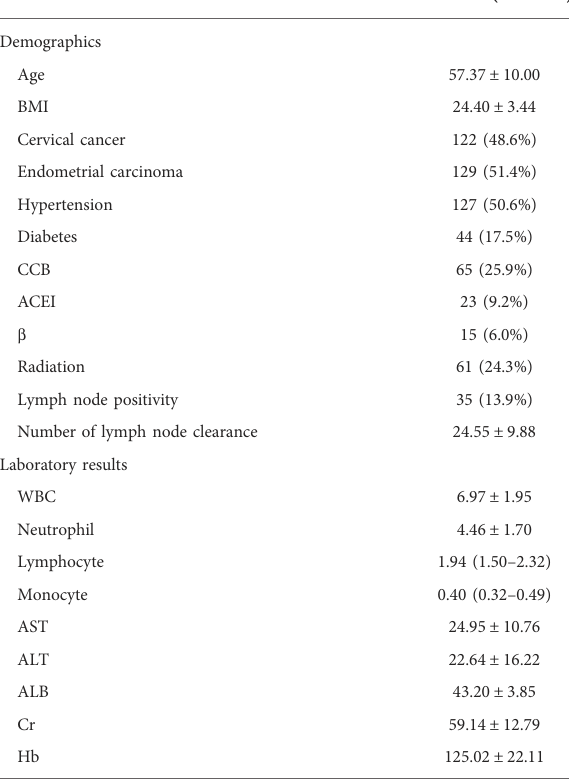
TABLE 1 Patient ’ s